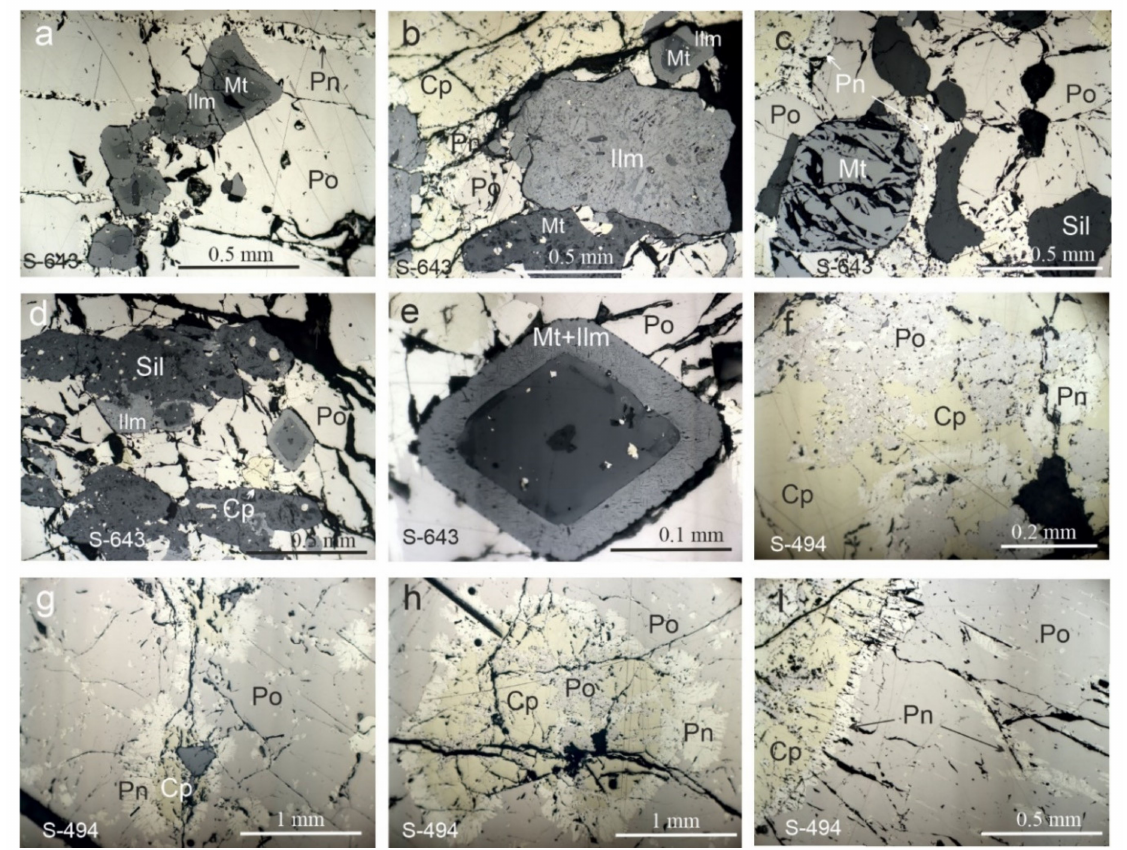
Figure 4. Textures and parageneses of sulfides in massive ores from boreholes S-643 ( a – e ) and S-494 ( f – i ), reflected light. ( a ) Magnetite (Mt)–ilmenite (Ilm) zoned grains together with pentlandite veinlets in pyrrhotite (Po); ( b ) ilmenite-grain-bearing sphene and perovskite lamellae and sulfide microinclusions; ( c ) droplet-shape magnetite grain in a sulfide matrix composed of pyrrhotite (Po), pentlandite (Pn), and chalcopyrite (Cp); ( d – e ) crystals of ulvospinel with apatite in core, surrounded by a zone of magnetite–ilmenite (Mt + Ilm) exsolutions; ( f – i ) chalcopyrite segregations surrounded by a rim of pentlandite, in